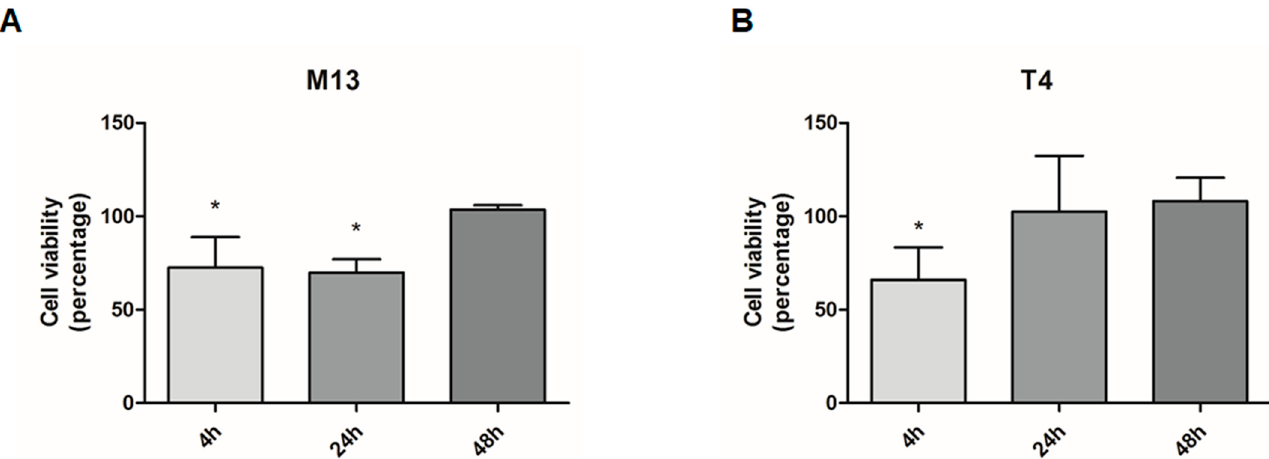
Figure 2. Viability of prostate cell line LNCaP after exposure to 10 7 pfu/mL of bacteriophages M13 and T4 for 4, 24, and 48 h. ( A ) The viability of LNCaP cells after treatment with M13 decreased significantly at 4 and 24 h ( p < 0.05). ( B ) LNCaP cell viability after T4 exposition showed a significant reduction at 4 h ( p < 0.05). Data are expressed in percentage related to untreated cells. * p < 0.05 vs. the control group within the same period of observation.